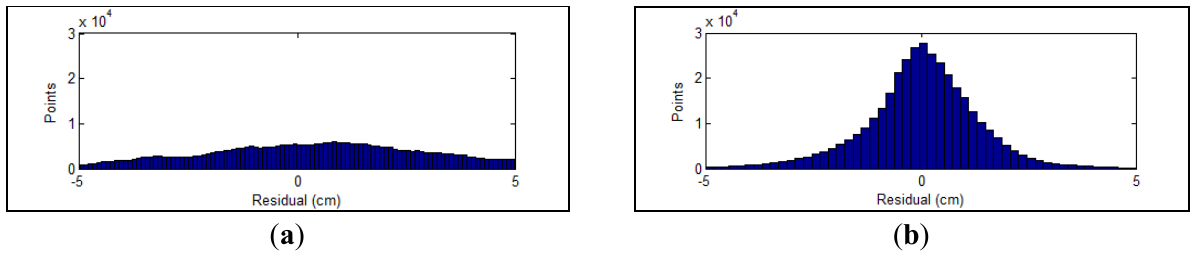
Figure 9. Distribution of point residuals ( a ) factory parameters; ( b ) recalibrated parameters.